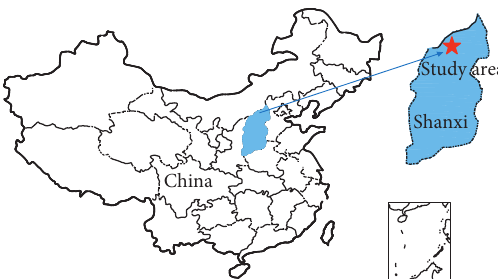
Figure 1: Location of coal mine in Datong city, Shanxi Province,